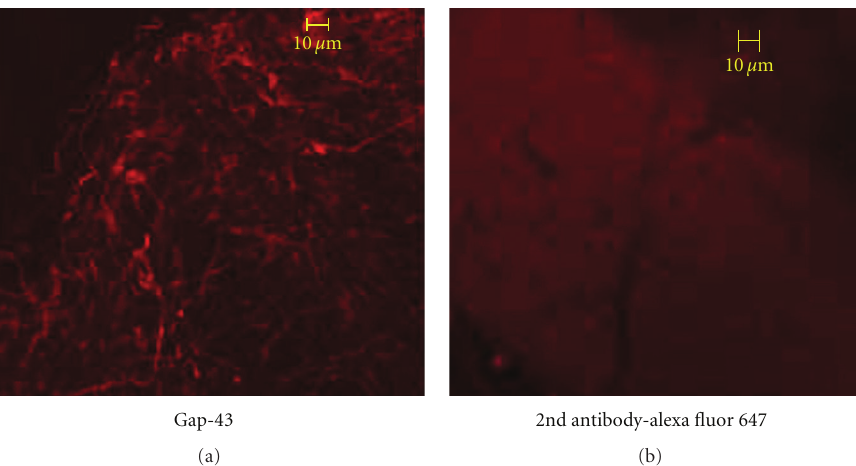
Figure 2: Immunofluorescent confocal analysis of the whole mount rat MBA expressing Gap-43. The whole mount of adult rat mesenteric arterial adventitia expresses 37 ± 4% Gap-43 (in red, alexa fluor-647) under scanning fluorescent confocal microscopy—20x. (Representative of 3